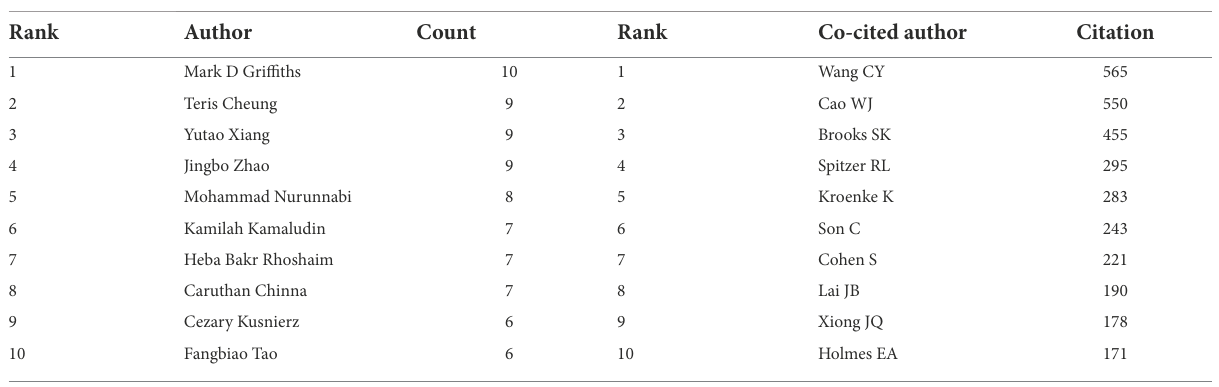
TABLE 3 Top 10 productive authors and co-cited authors related to ferroptosis.